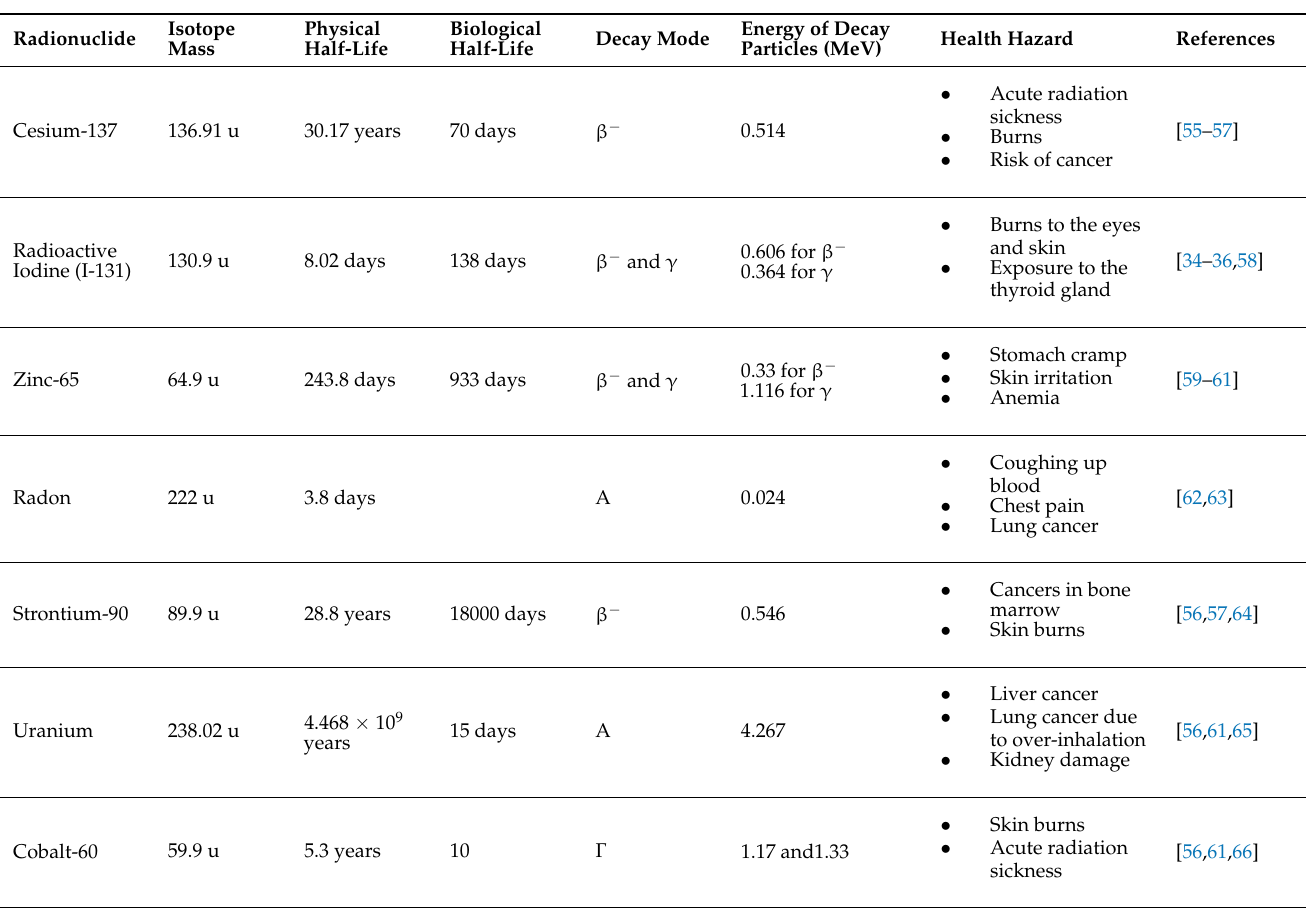
Table 1. Concerned radionuclides and their